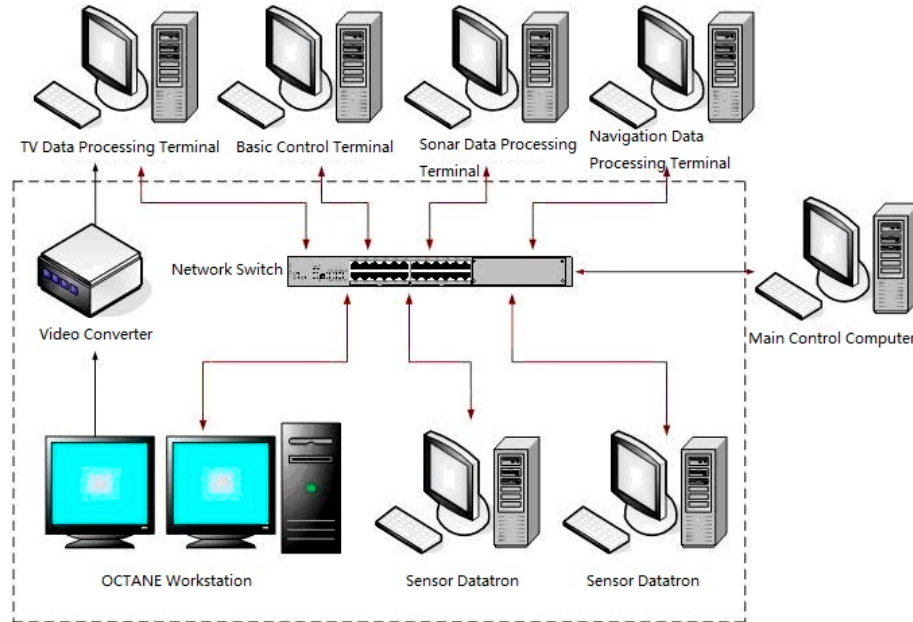
Figure 10. MUSVs integrated simulation system.